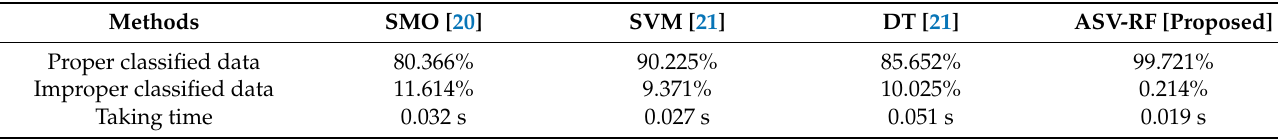
Table 2. Proper and improper classified data.